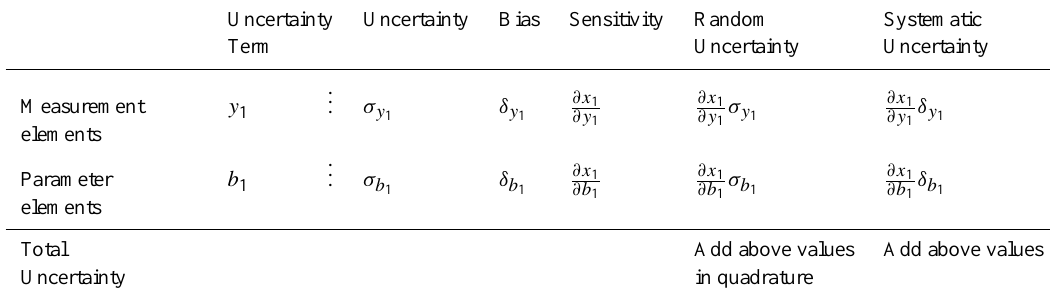
Table 2. Example of an error budget. Uncertainty Uncertainty Bias